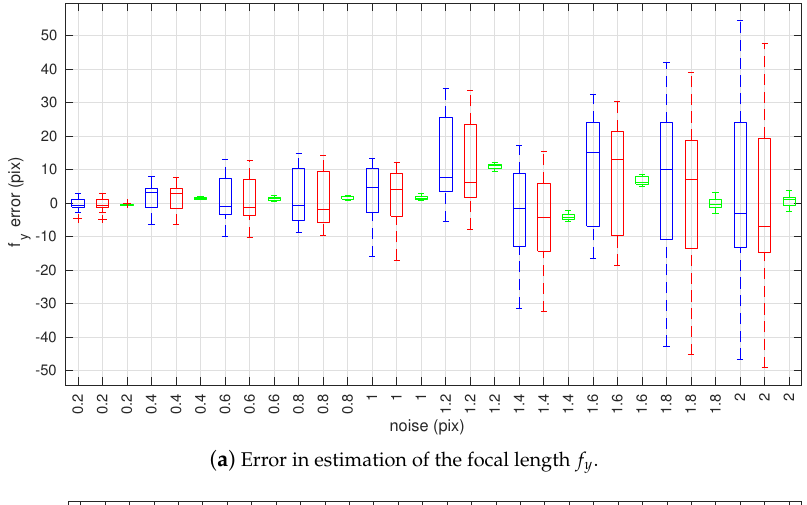
( a ) Error in estimation of the focal length f y .